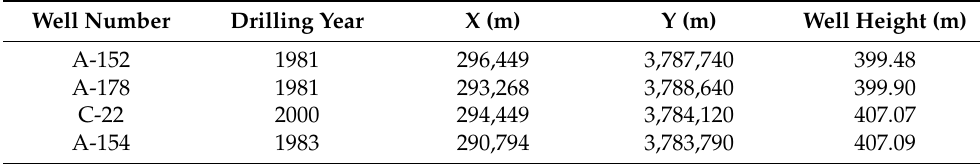
Table 2. The baseline information of four old wells.